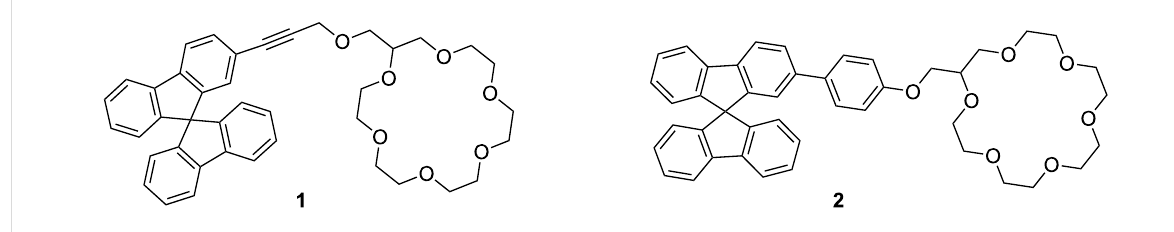
Figure 2: Concave templates 1 and 2 .